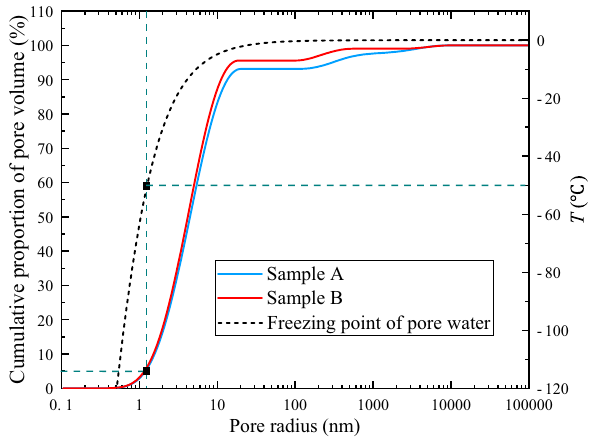
Figure 9. Relationship between pore radius and pore water freezing